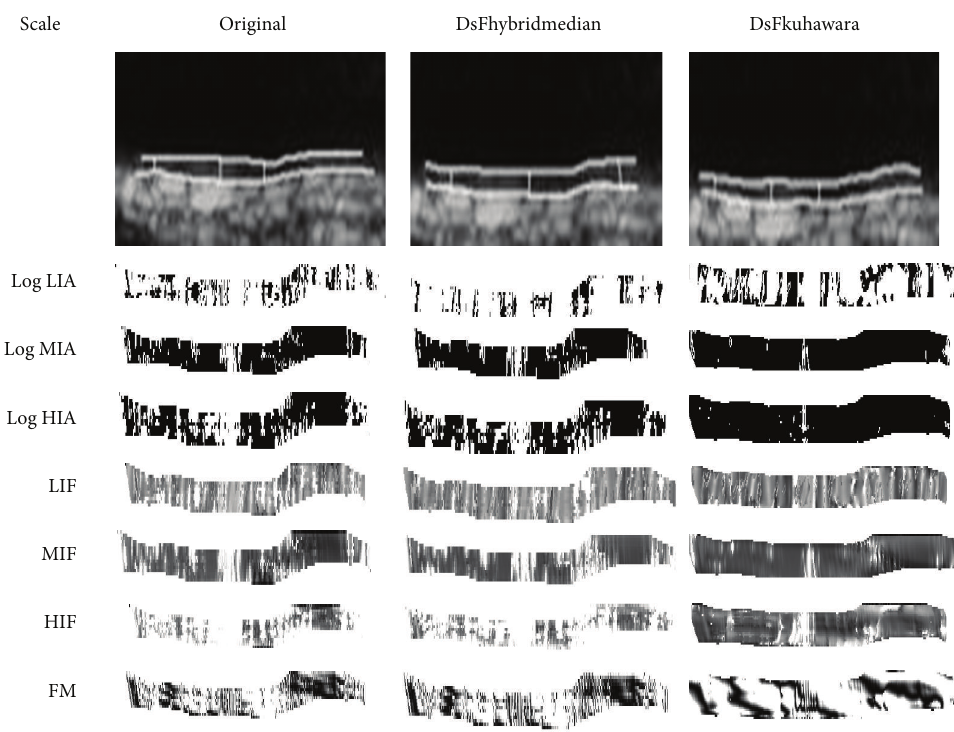
Figure 3: AM-FM analysis of the IMC original (1st column) and despeckled images with the DsFhybrimedian (2nd column) and DsFkuhawara (3rd column), from a male asymptomatic subject aged 49. In the 1st row, the IMT measurements of the original (IMT aver = 0.66 mm, IMT max = 0.827 mm, IMT min = 0.526 mm, IMT median = 0.68), DsFhybrimedian (IMT aver = 0.69 mm, IMT max = 0.91 mm, IMT min = 0.53 mm, IMT median = 0.69), and DsFkuhawara (IMT aver = 0.63 mm, IMT max = 0.77 mm, IMT min = 0.49 mm, IMT median = 0.63 mm) are shown. In the following rows we present the AM-FM components of the instantaneous amplitude of Log of LIA, MIA, and HIA, and of instantaneous frequency of LIF, MIF, and HIF. The last row shows the FM demodulation (integral of the IF) of the images in the low frequencies. For better visualization, the images have been interpolated to be 300 × 20